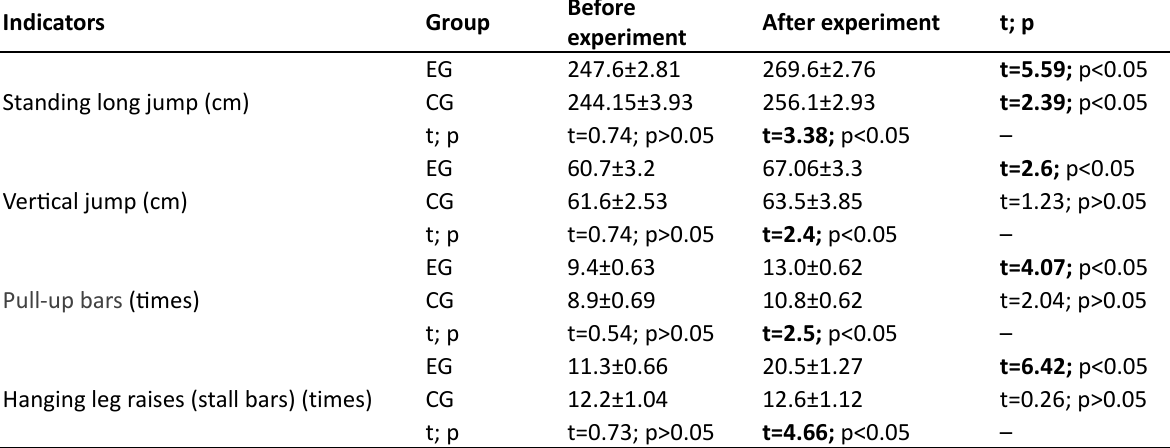
Table 1. Comparative analysis of indicators in basketball players of 18-19 years old